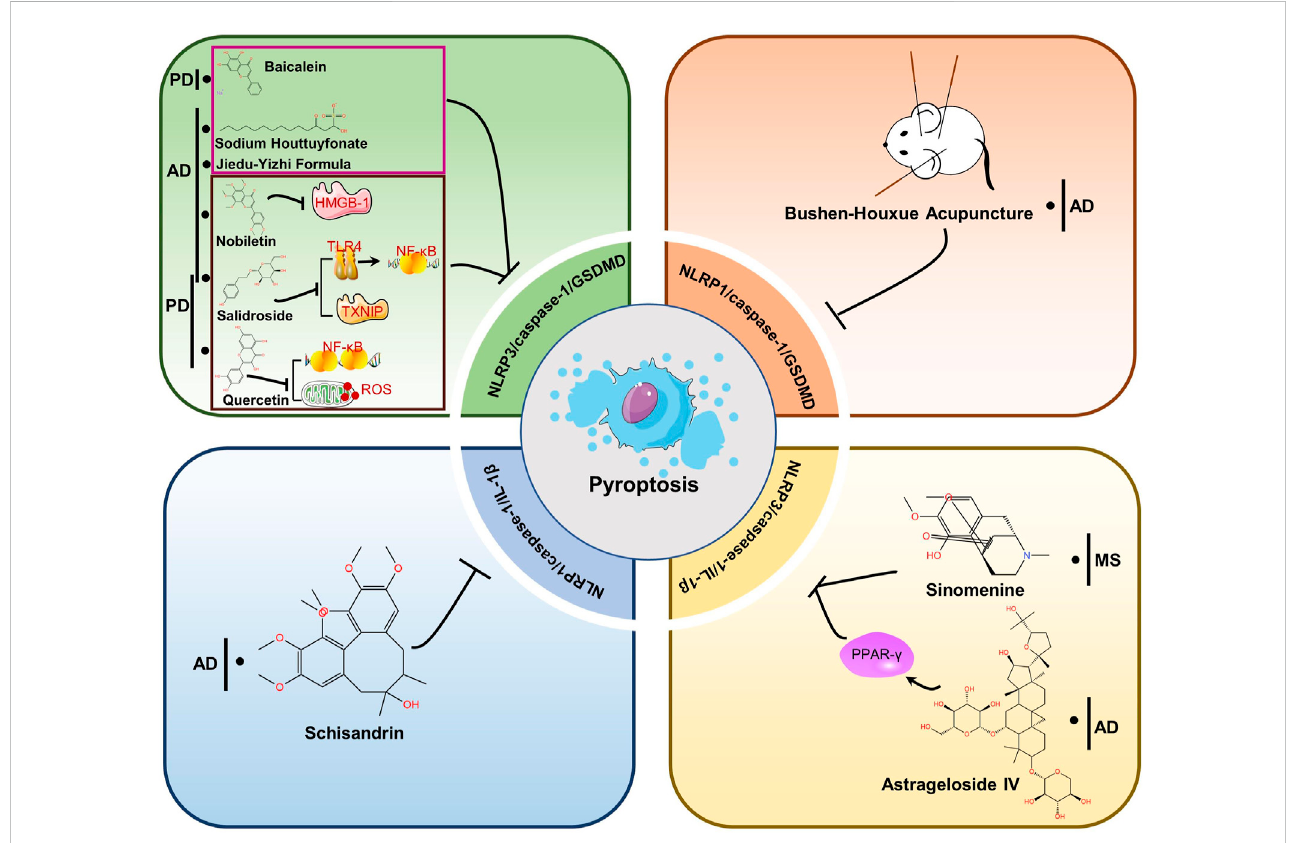
FIGURE 4 Therapeutic strategies of TCMs for treating NDs by targeting pyroptosis. Baicalein, Sodium Houttuyfonate and Jiedu-Yizhi Formula attenuated neuronal pyroptosisbyinhibitingNLRP3/caspase-1/GSDMDpathway.ByreducingtheexpressionofHMGB-1,NobbiletinsuppressesNLRP3anddiminishespyroptosis. Salidroside inhibited either the TLR4/NF- κ B pathway or the expression of TXNIP and downregulated the expression of NLRP3, caspase-1 and GSDMD, thus inhibiting pyroptosis to restore neuronal function. Quercetin prevents the generation of NF- κ B and ROS, which prevents NLRP3 from being activated. The NLRP1/caspase-1/GSDMD pathway is blocked by Bushen-Houxue Acupuncture, which prevents pyroptosis from occurring. Schisandrin prevents pyroptosis by blocking the NLRP1-caspase-1-IL-1 β axis. Sinomenine and Astrageloside IV, however, inhibit the NLRP3-caspase-1-GSDMD